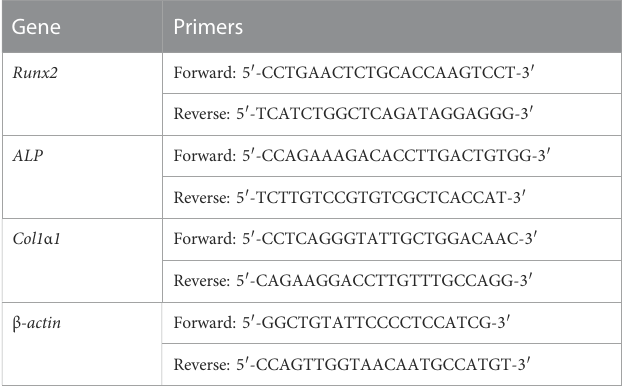
TABLE 1 Primer pairs used in RT-PCR analysis.